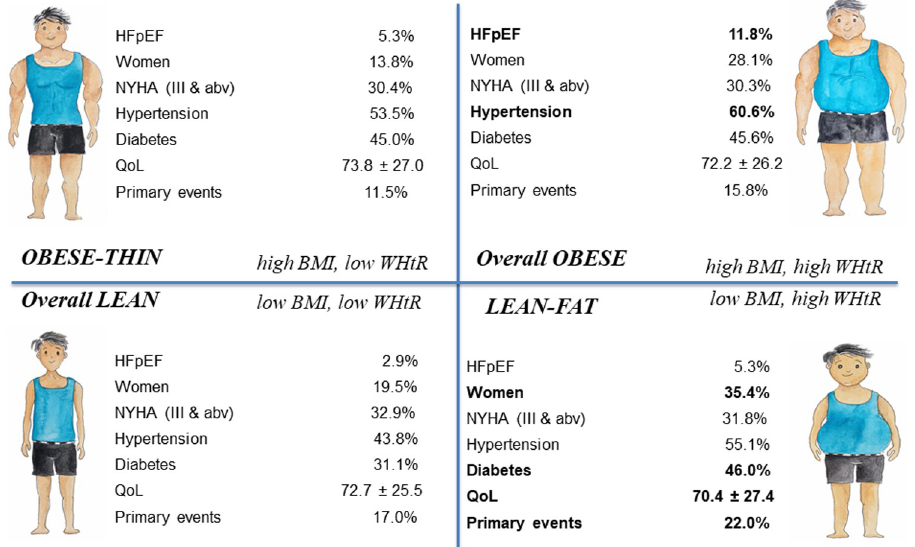
Fig 1. Central illustration of 4 combined groups of BMI (high, � 24.5 kg/m 2 [obese], or low, < 24.5 kg/m 2 [lean]) and waist-to-height ratio (high, � 0.55 [fat], or low, < 0.55 [thin]). QoL refers to the Kansas City Cardiomyopathy Questionnaire total symptom score. Key differences in characteristics between BMI/WHtR groups in bold. abv, above; BMI, body mass index; HFpEF, heart failure with preserved ejection fraction; NYHA, New York Heart Association; QoL, quality of life; WHtR, waist-to-height